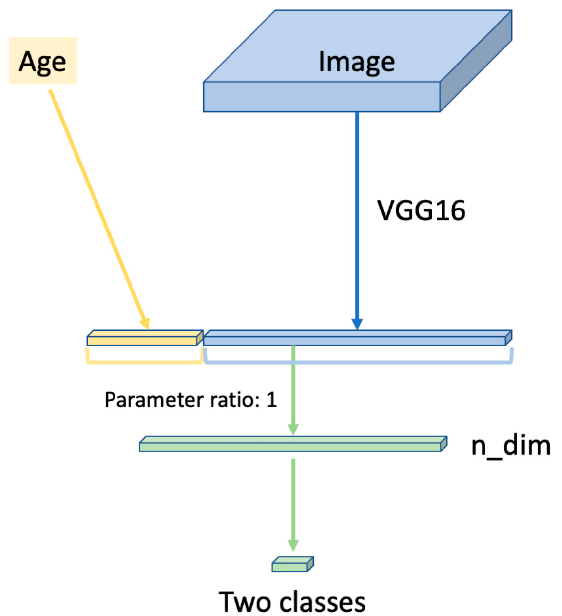
Figure 3. Overall architecture of the neural network model used in this study. VGG: Visual Geom- etry Group.